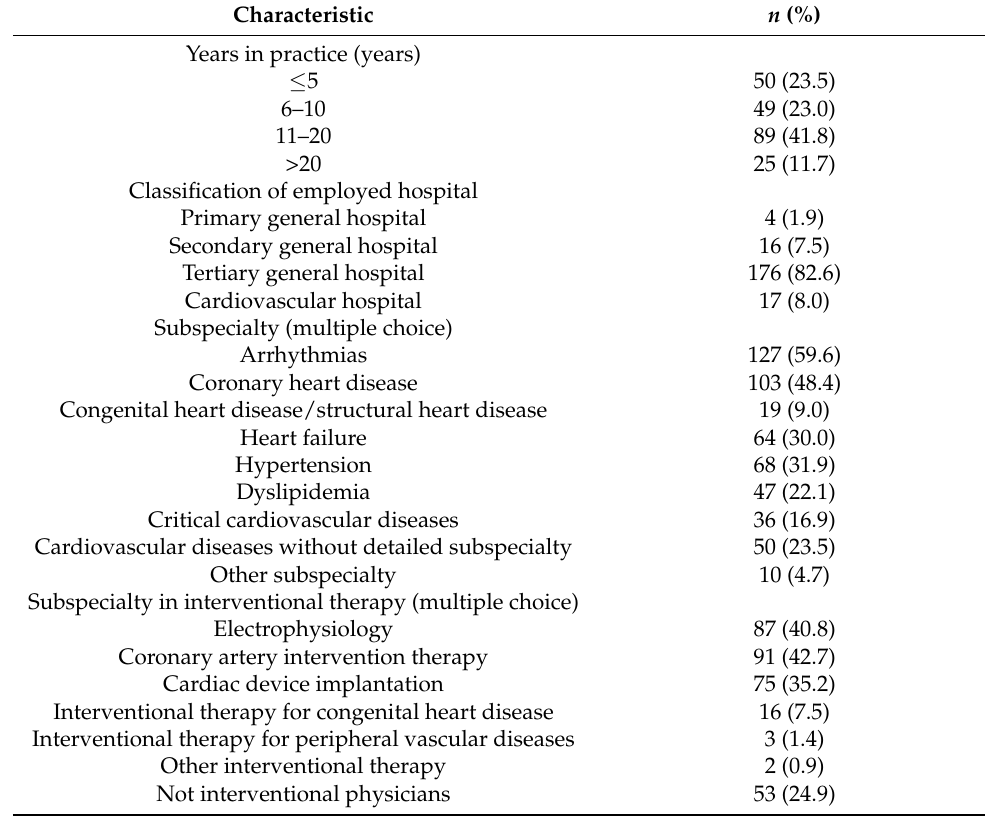
Table 1. Characteristics of survey respondents ( n = 213).